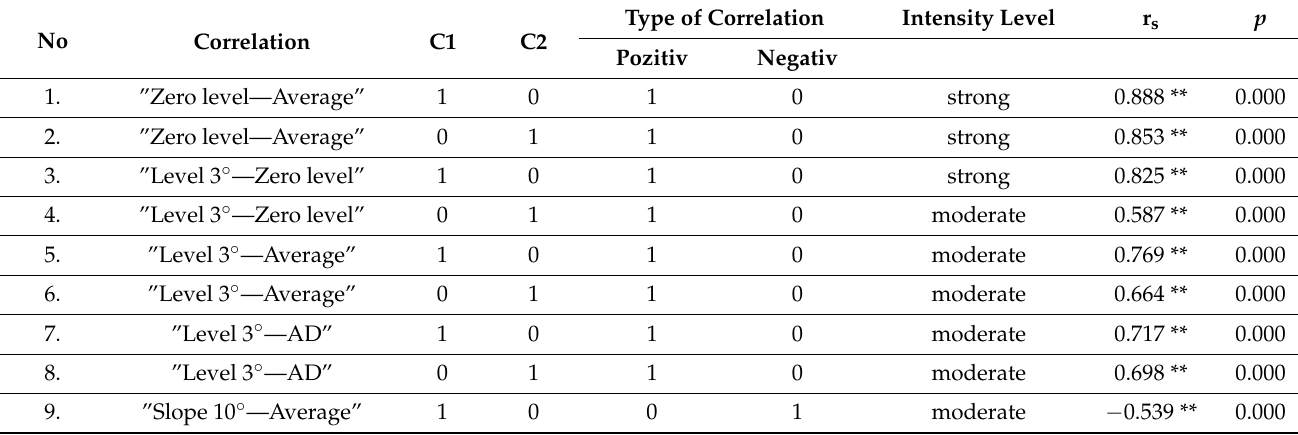
Table 11. Distribution of moderate-intensity correlations between “Visual Field” parameters in patients with NTG, at the first consultation (C1) and at the last consultation (C2).